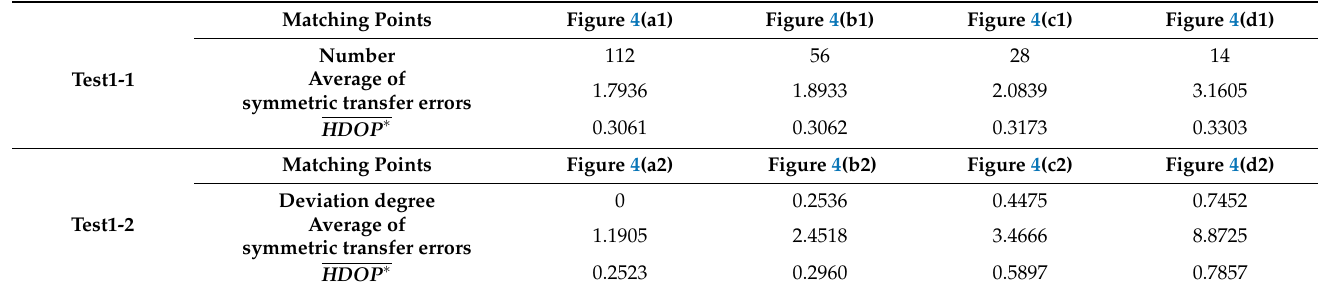
Table 1. Results calculated by the matching points in Experiment I.